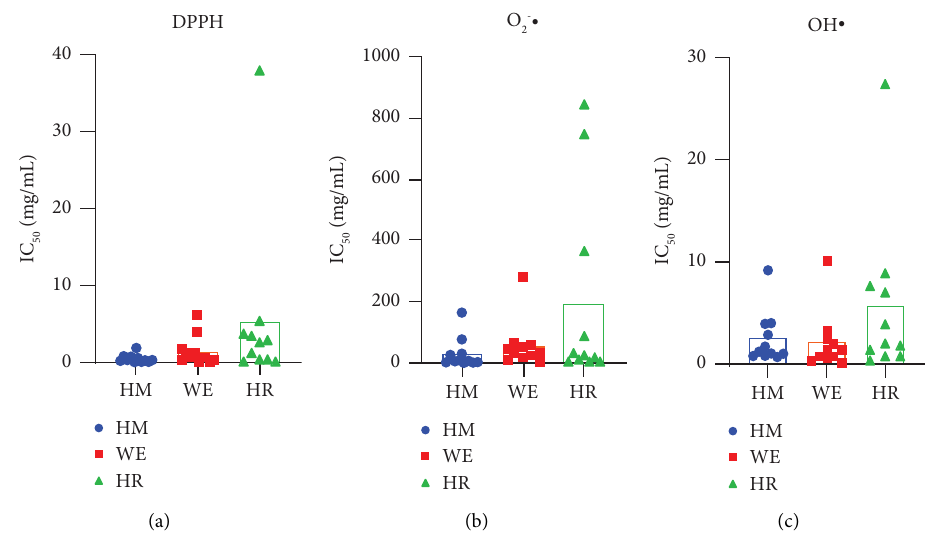
Figure 5: Column chart of IC50 of diferent forms for 11 batches of C. tubulosa samples.